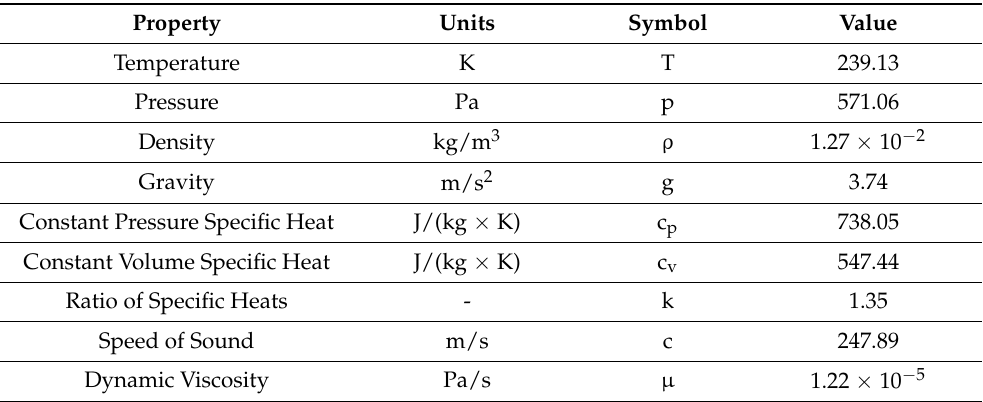
Table 1. Martian environmental properties at h alt = 100